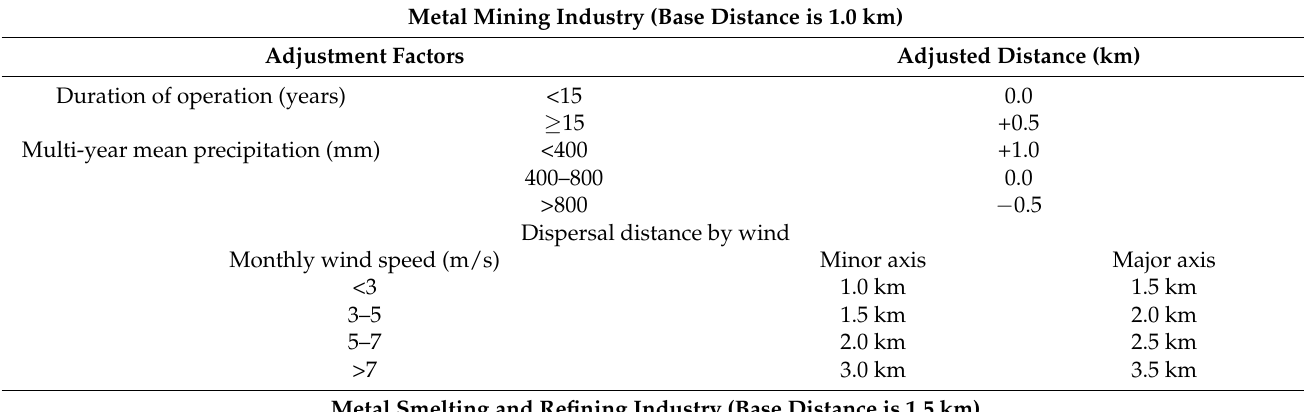
Table 2. Dispersal distances from metal mining, smelting, and refining industries [42]. Metal Mining Industry (Base Distance is 1.0 km)